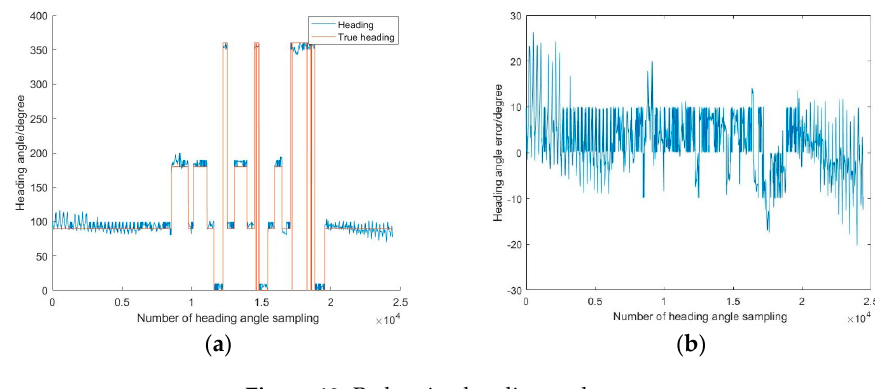
Figure 10. Pedestrian heading and error.